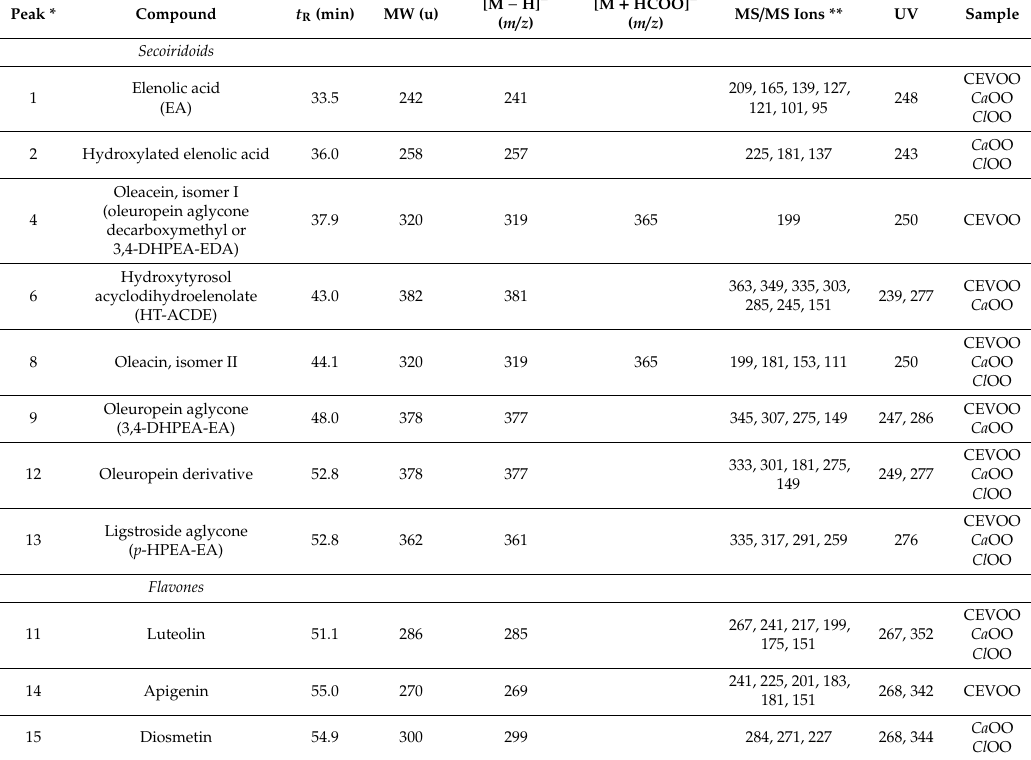
Table 6. Chromatographic, UV, and ESI-MS / MS data of chemical constituents detected in control (CEVOO), Citrus x aurantium peel ( Ca OO), and Citrus limon peel ( Cl OO) olive oil